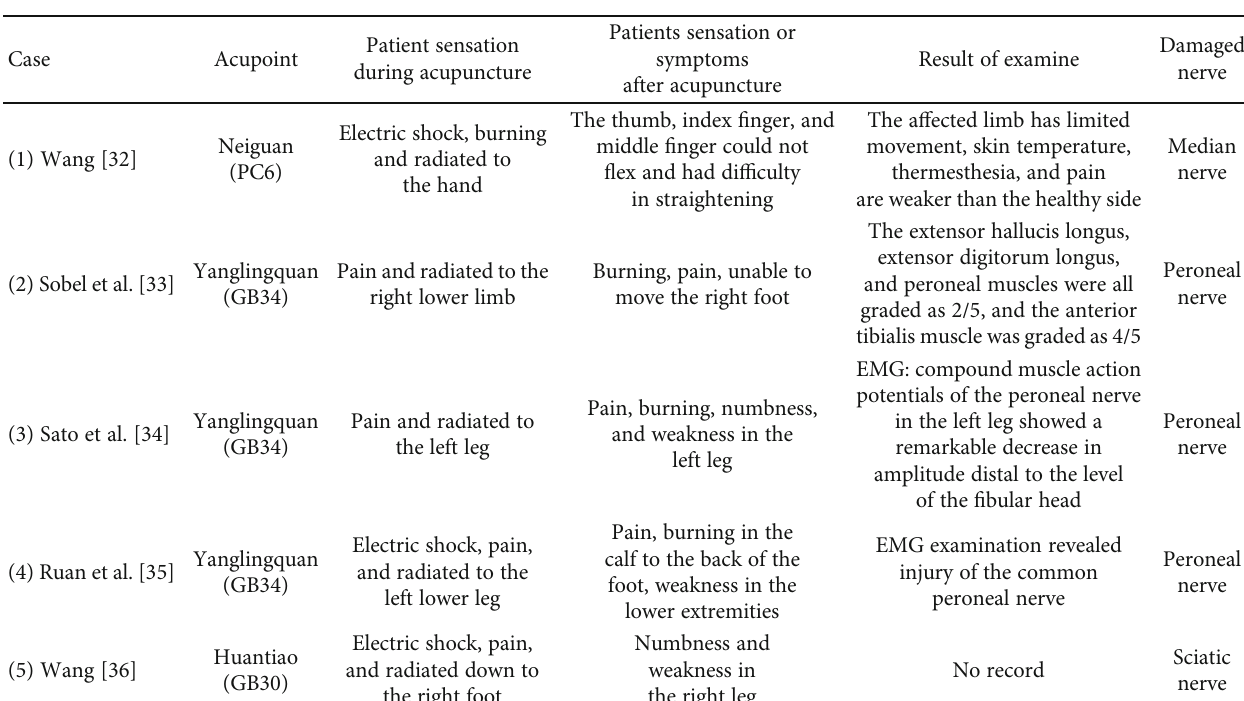
Table 2: Peripheral nerve injury associated with